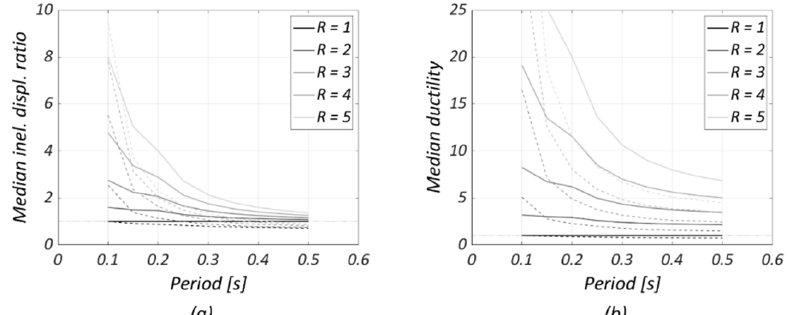
Figure 11. Comparison between the predictions by the DCM of ASCE 41-17 (solid lines) and the results from NLTHA of Suite 2-A (dashed lines): ( a ) median C R − R − T curves, and ( b ) median µ R − R − T curves.